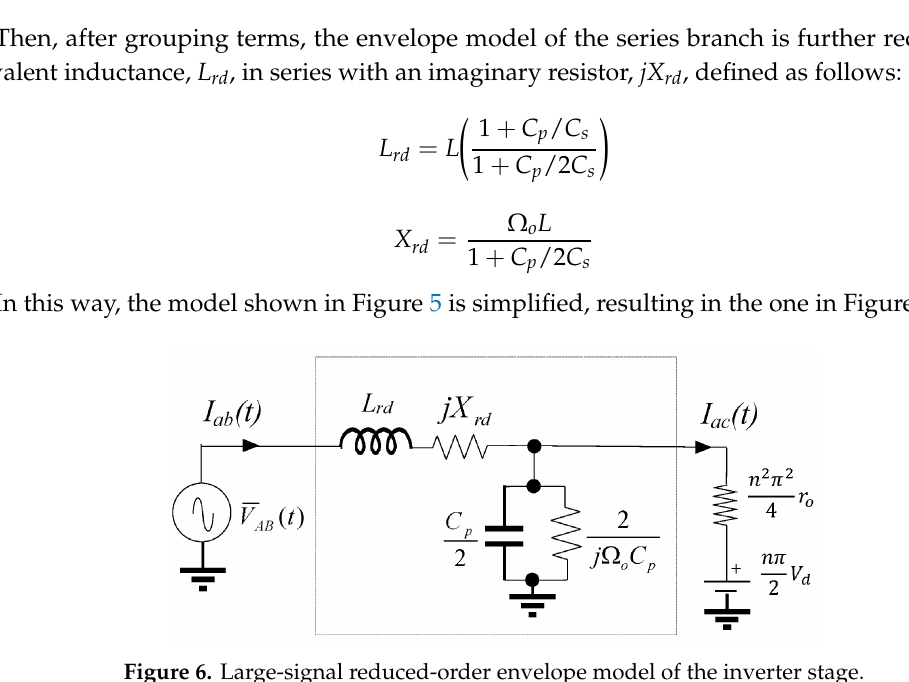
Figure 5. Large-signal envelope model of the inverter stage.